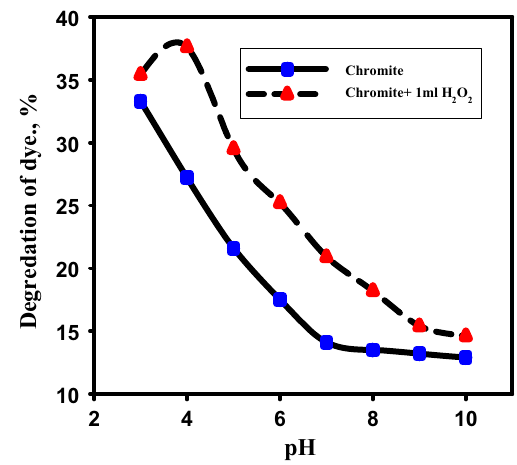
Fig. 7 Effect of the initial solution pH on the removal